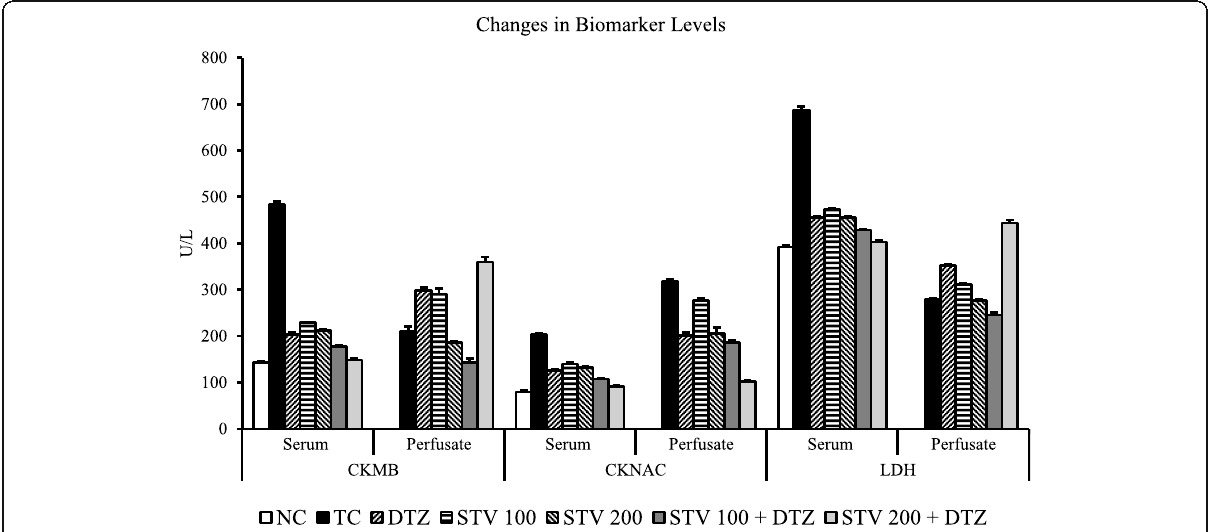
Fig. 2 Effects of STV, DTZ, and their combinations of levels of CKMB, CKNAC, and LDH levels in serum and perfusate